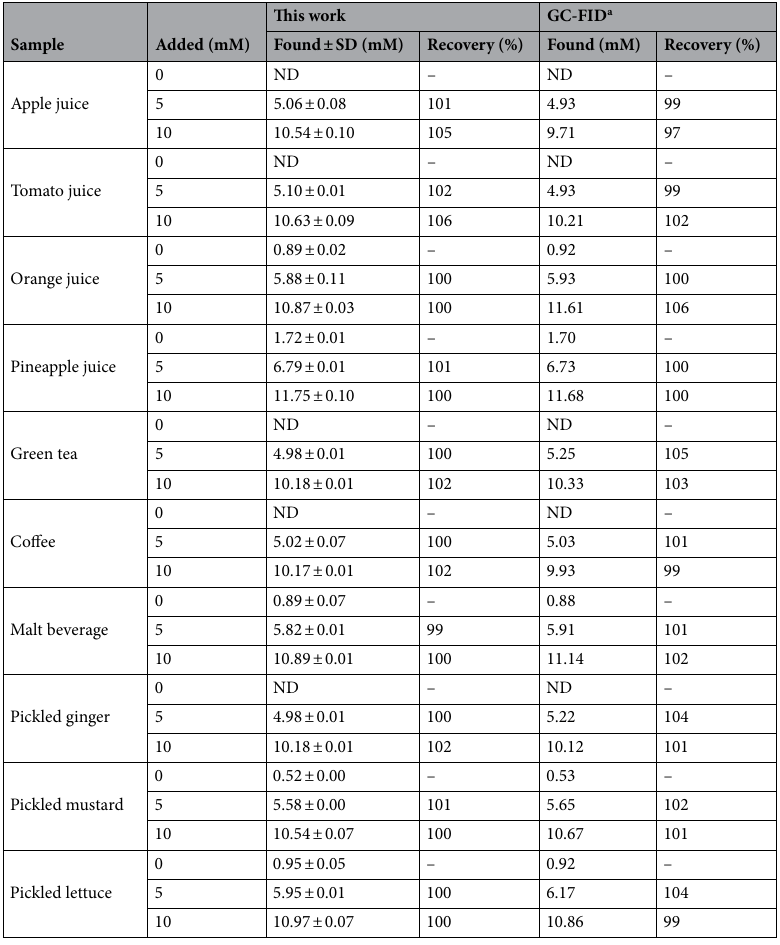
punched to form a circular hole with a diameter of 0.3 cm. Acrylic double-sided adhesive was used to attach the screen-printed electrode with a circular hole onto the BDD electrode. The obtained electrochemical sensor consisted of a Ag/AgCl reference electrode, a carbon counter electrode, and a BDD working electrode with a geometric area of 0.07 cm 2 .